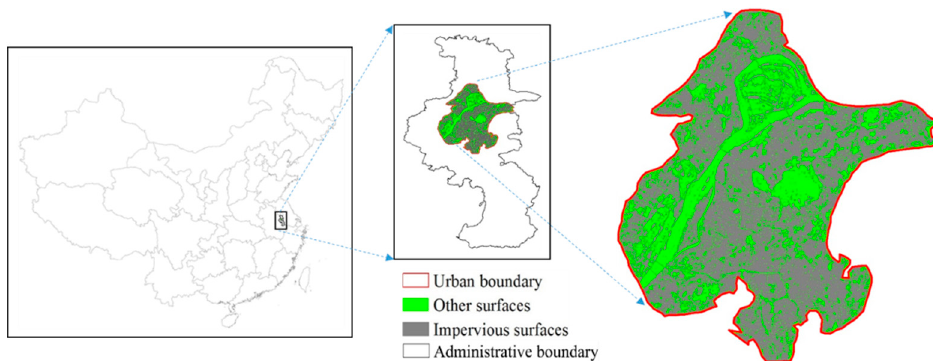
Figure 2. Urban area of Nanjing in 2010. The red contour outlines the urban boundary. Green areas are other surfaces, for instance, water, vegetation, or soil. Gray areas are impervious surfaces.